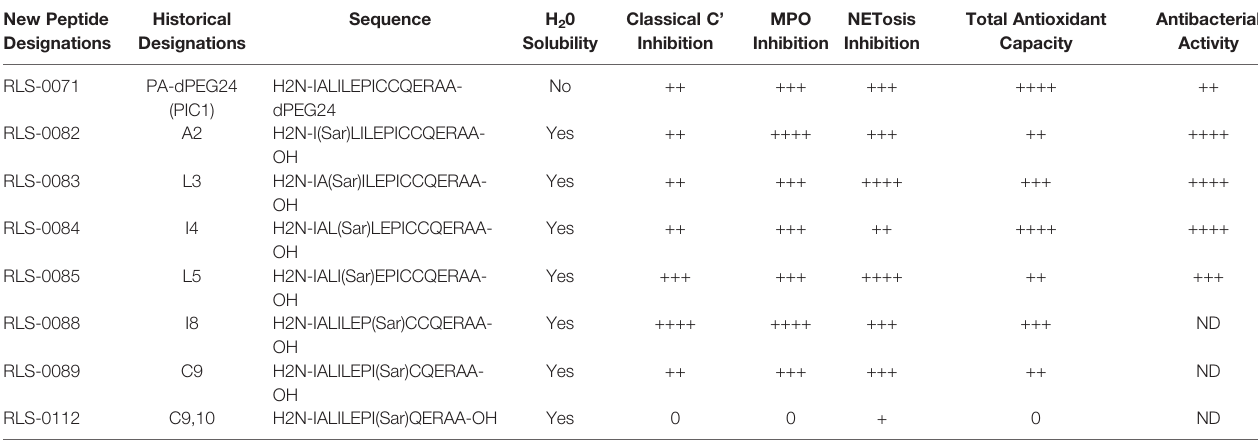
TABLE 1 | Summary of EPICC peptide